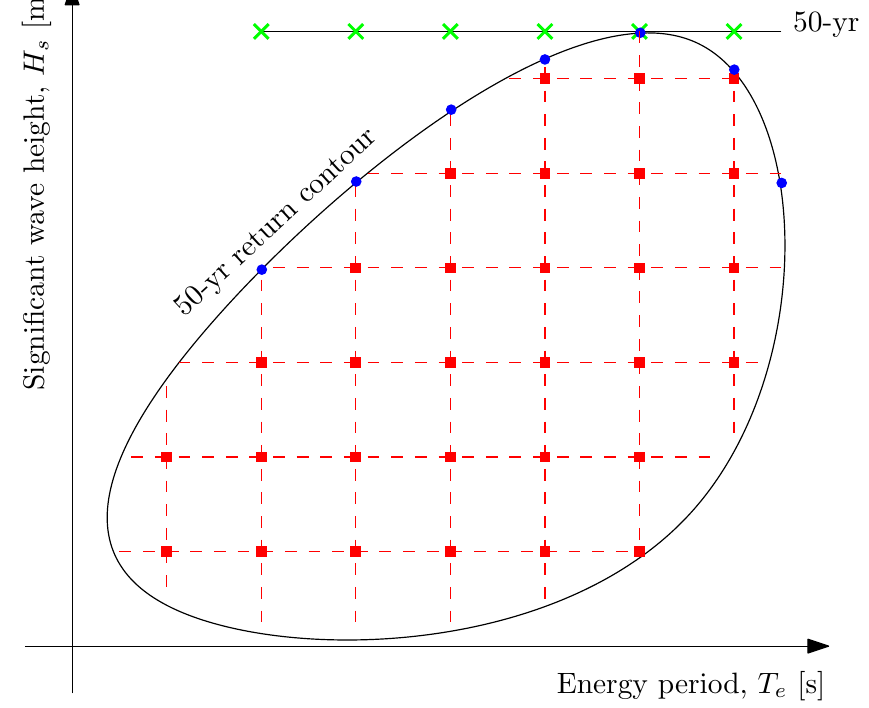
Figure 2. Frameworks for survival/extreme response WEC design cases: all sea state approach shown in red squares; contour approach shown in blue disks; 1D approach shown in green “X”